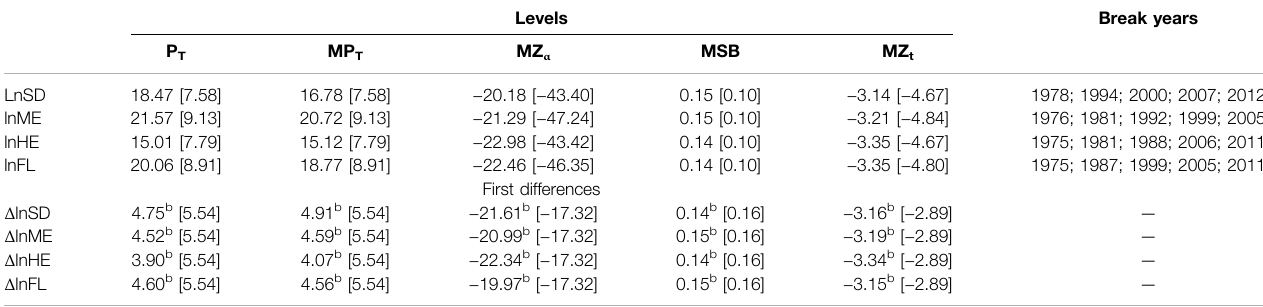
TABLE 3 | The quasi-GLS based Unit Root Tests under Multiple Structural